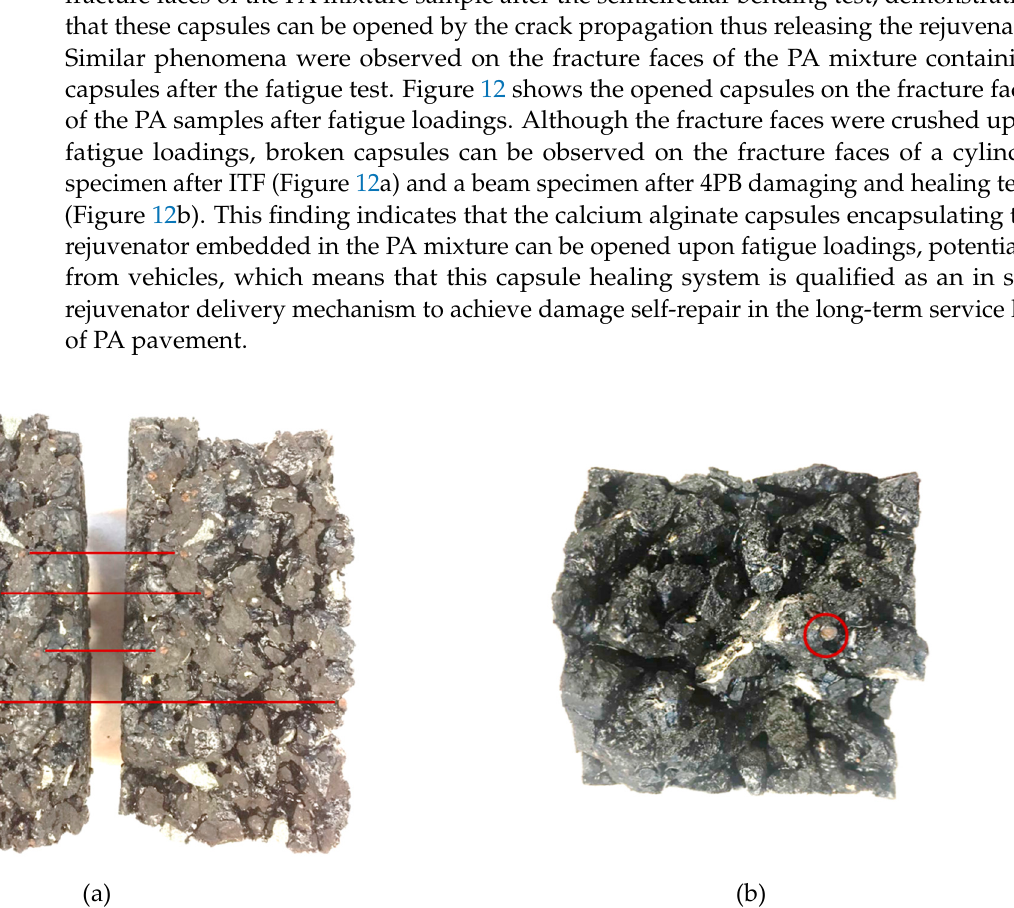
Figure 12. The opened capsules on fracture faces after fatigue loadings: ( a ) fracture faces of a cylinder specimen after ITF and ( b ) fracture face of a beam specimen after 4PB damaging and healing tests.